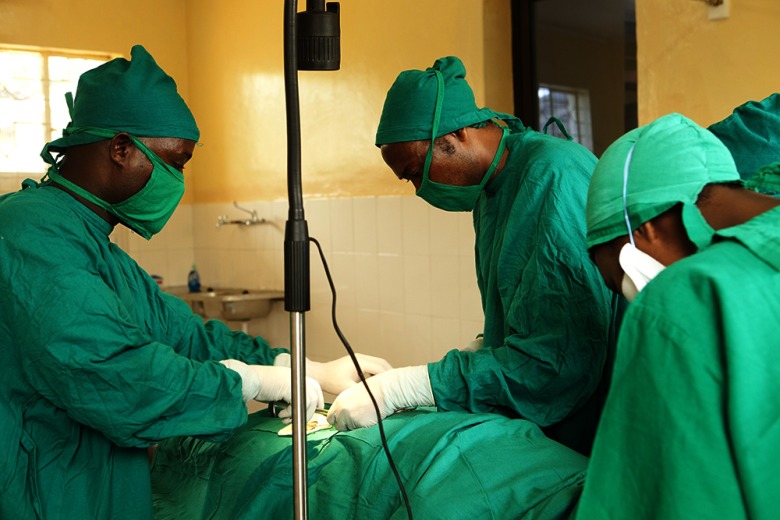
A woman undergoes tubal ligation by minilaparotomy in a health facility in northern Tanzania. © 2015 EngenderHealth/S. Lewis